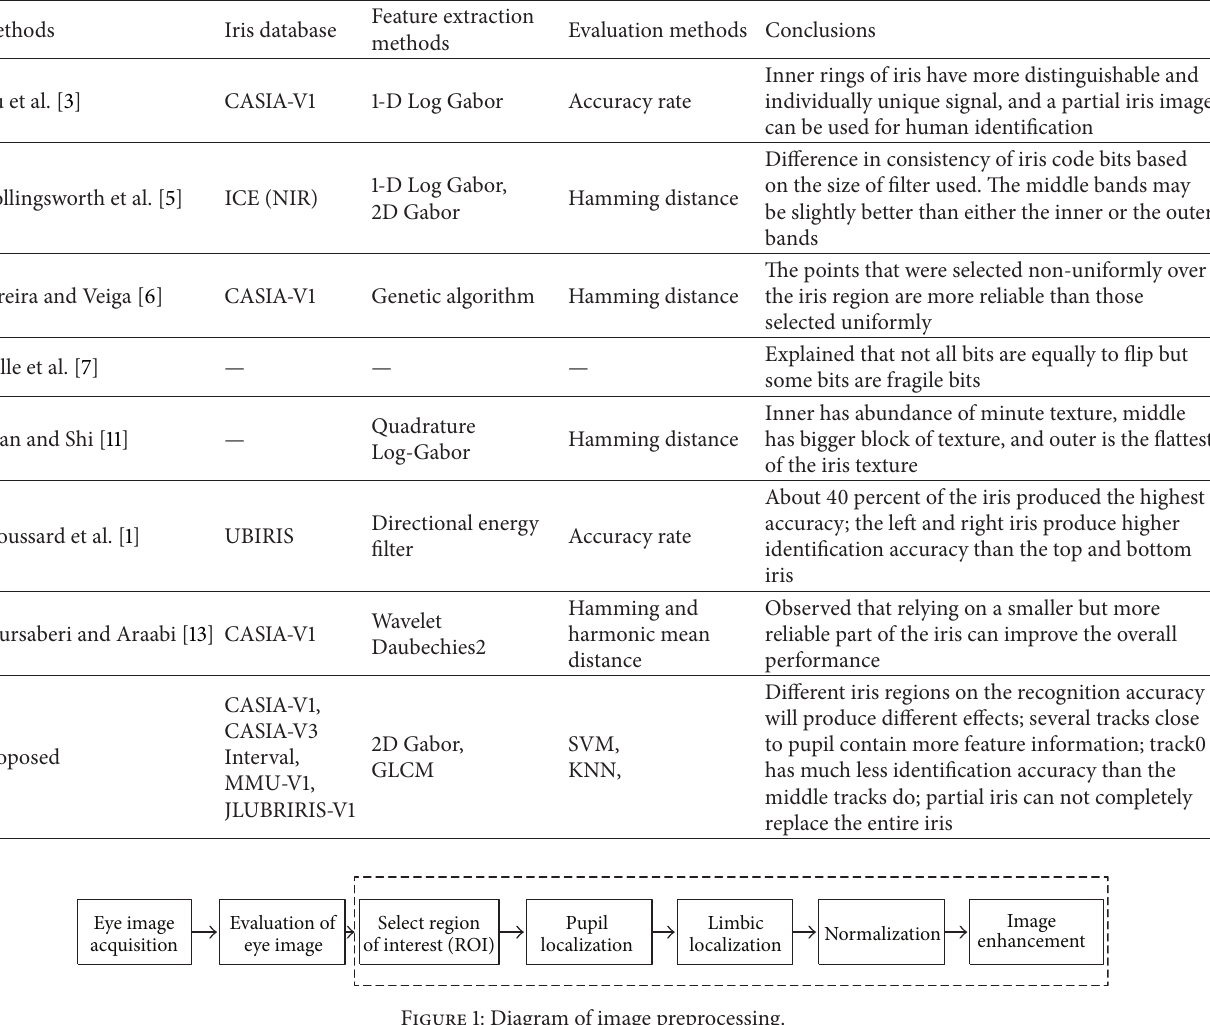
Figure 1: Diagram of image